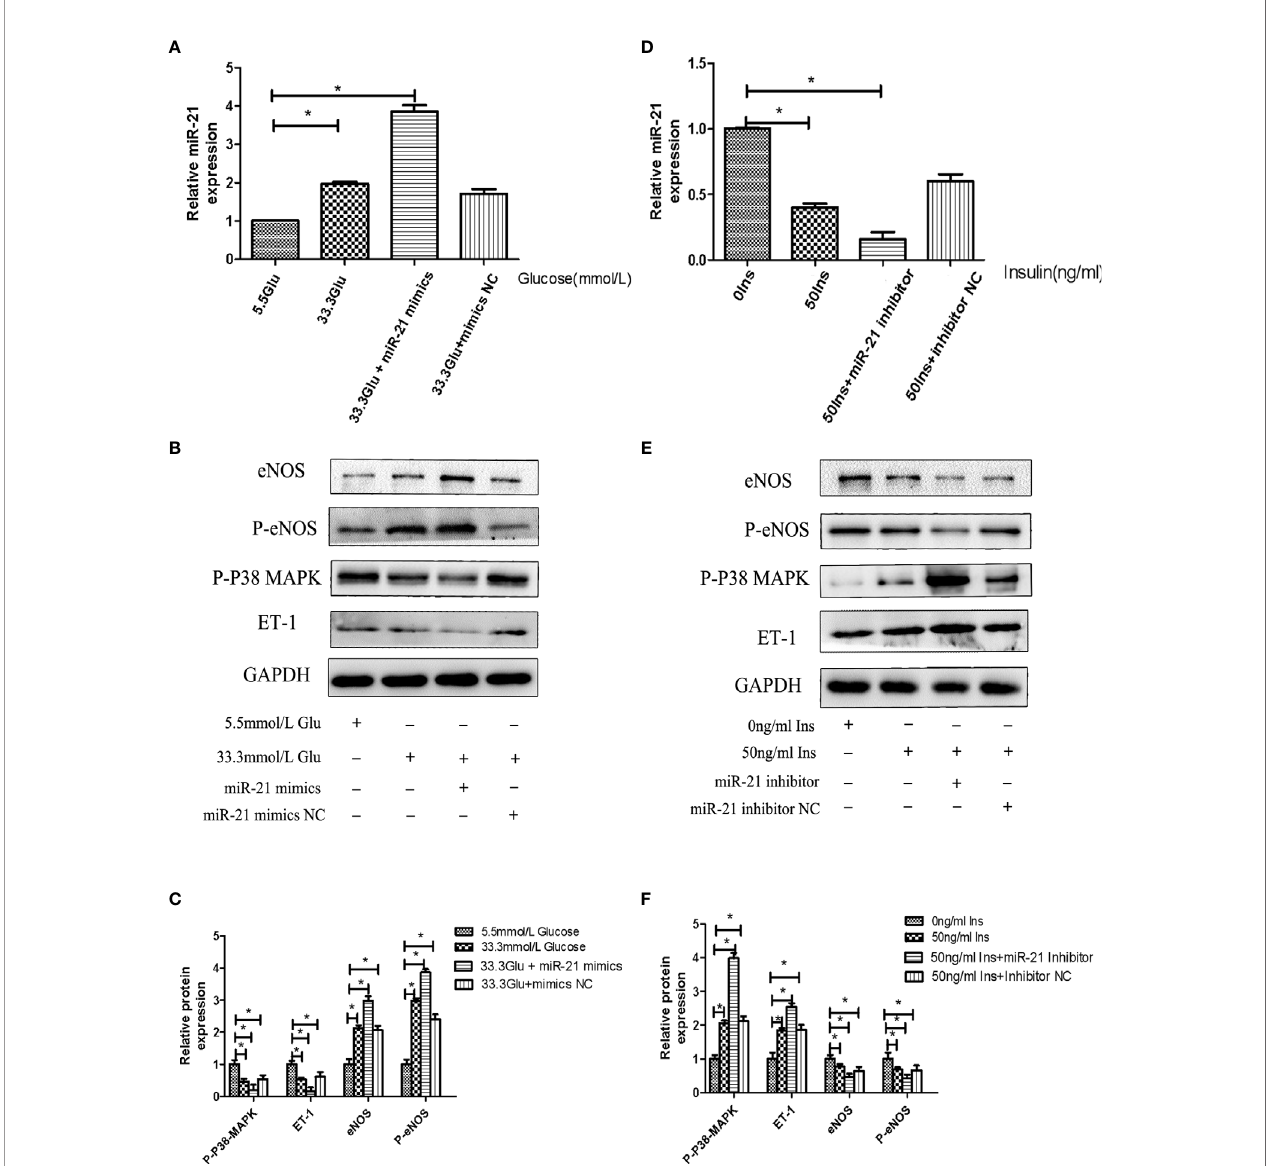
FIGURE 5 | MiR-21 mimics/inhibitor enhanced the impact that high concentration glucose/insulin had on downstream pathways. (A) : qRT-PCR analysis of miR-21 in HGECs transfected with miR-21 mimics or mimics NC and treated with different concentrations of glucose. (B) : Westernblot analysis of PTEN/AKT/eNOS and MAPK/ET-1 pathways in groups in (A). (C) : Quanti fi cation of result in (B). (D) MiR-21 levels in HGECs transfected with miR-21 inhibitor or inhibitor NC and treated with different concentrations of insulin. (E) : Westernblot analysis of PTEN/AKT/eNOS and MAPK/ET-1 pathways in groups in (D). (F) Quanti fi cation of result in (E) Data are reported as mean ± SD, *P < 0.05. All data are representative of three independent experiments. Glu, glucose; Ins, insulin; NC, normal